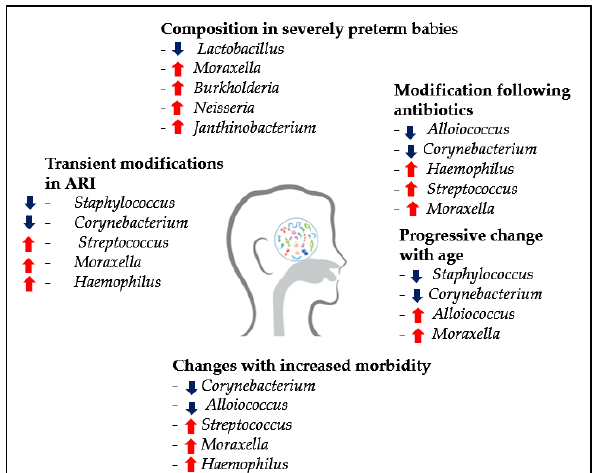
Figure 6. Non-exhaustive description of relative abundance of specific genera in the nasopharynx and changes associated with known influencing factors (e.g., age, antibiotic use and acute RTIs (respiratory tract infections)) [29]. Arrow up = associated with increase. Arrow down = associated with decrease.